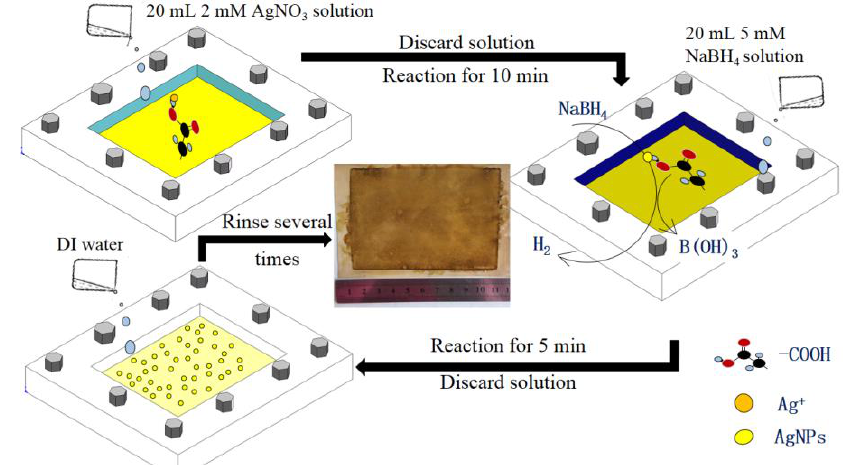
Figure 1. Sketch map of the preparation for an AgNP modified thin film composite-forward osmosis (TFC–FO) membrane.